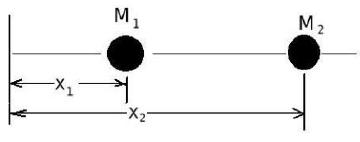
Figure 4. Center of mass two bodies.